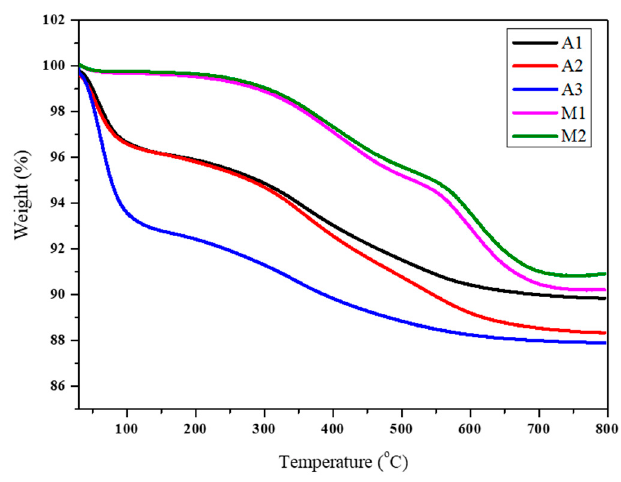
Figure 6. TGA curves of the hydrophilic MSPs (A1, A2, and A3) and the hydrophobic MSPs (M1 and M2).